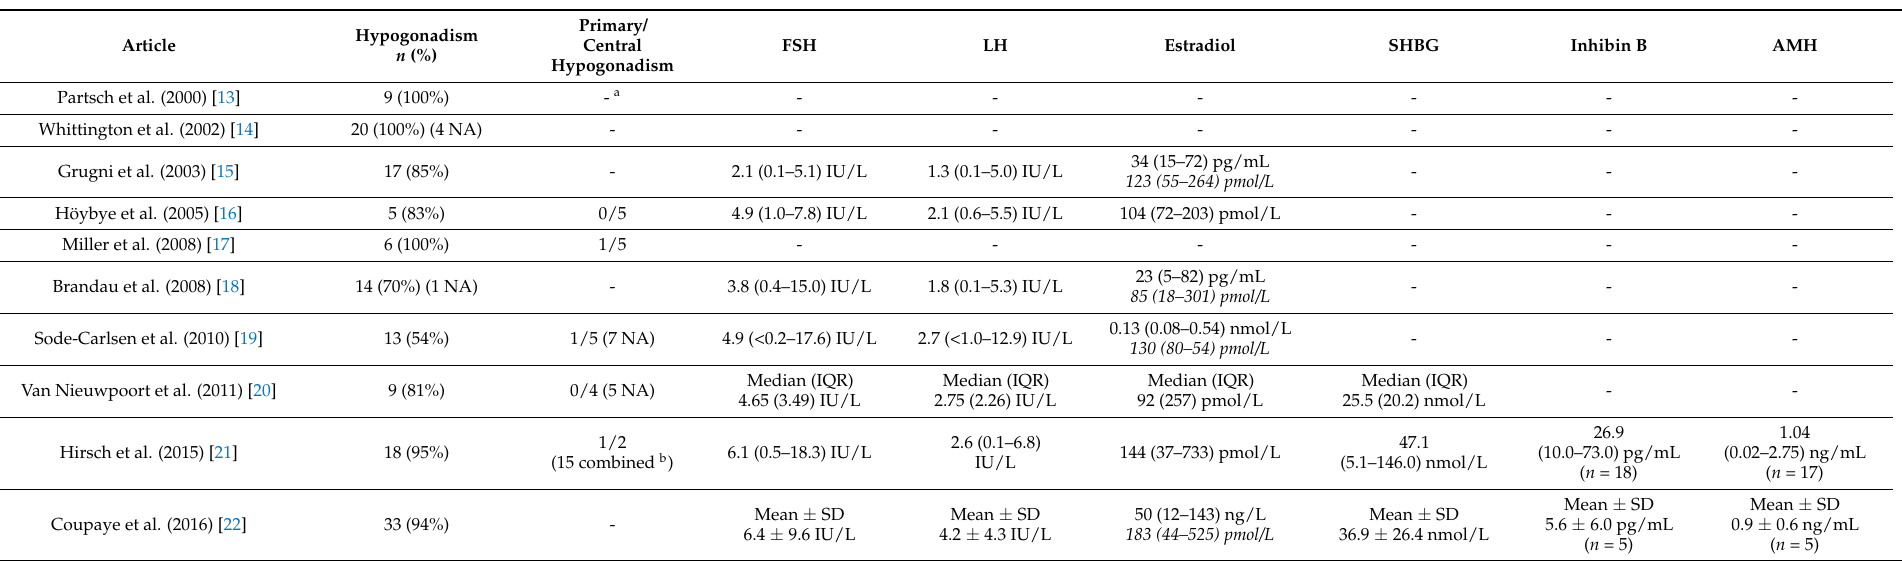
Table 5. Literature review of hypogonadism in women with Prader-Willi syndrome (Part